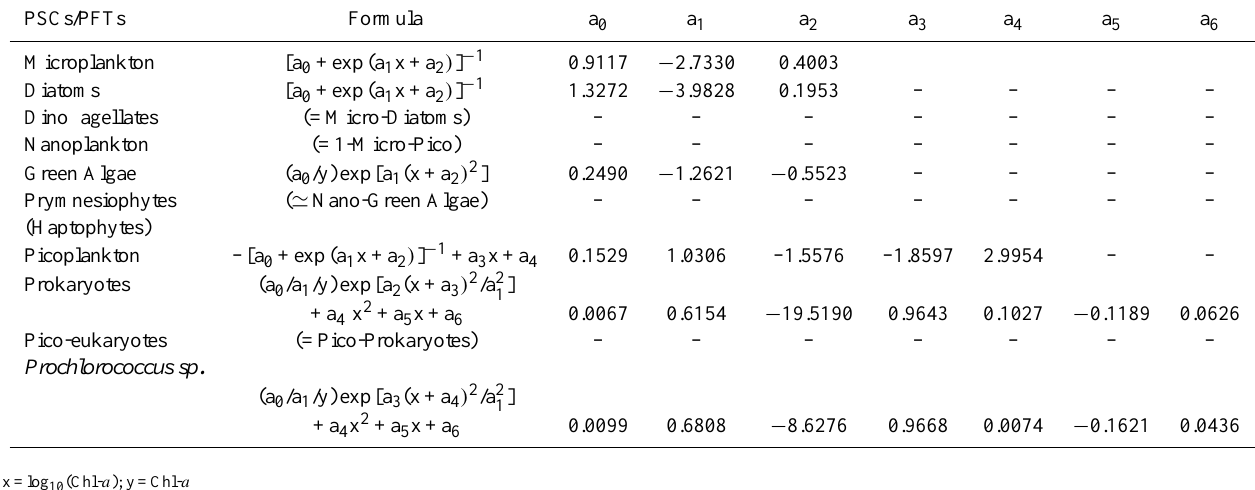
Table 2. Equations to estimate fractions [0.0–1.0] of PSCs (Micro-, Nano- and Picoplankton) and PFTs (other). Set PFT fraction to 1.0 if